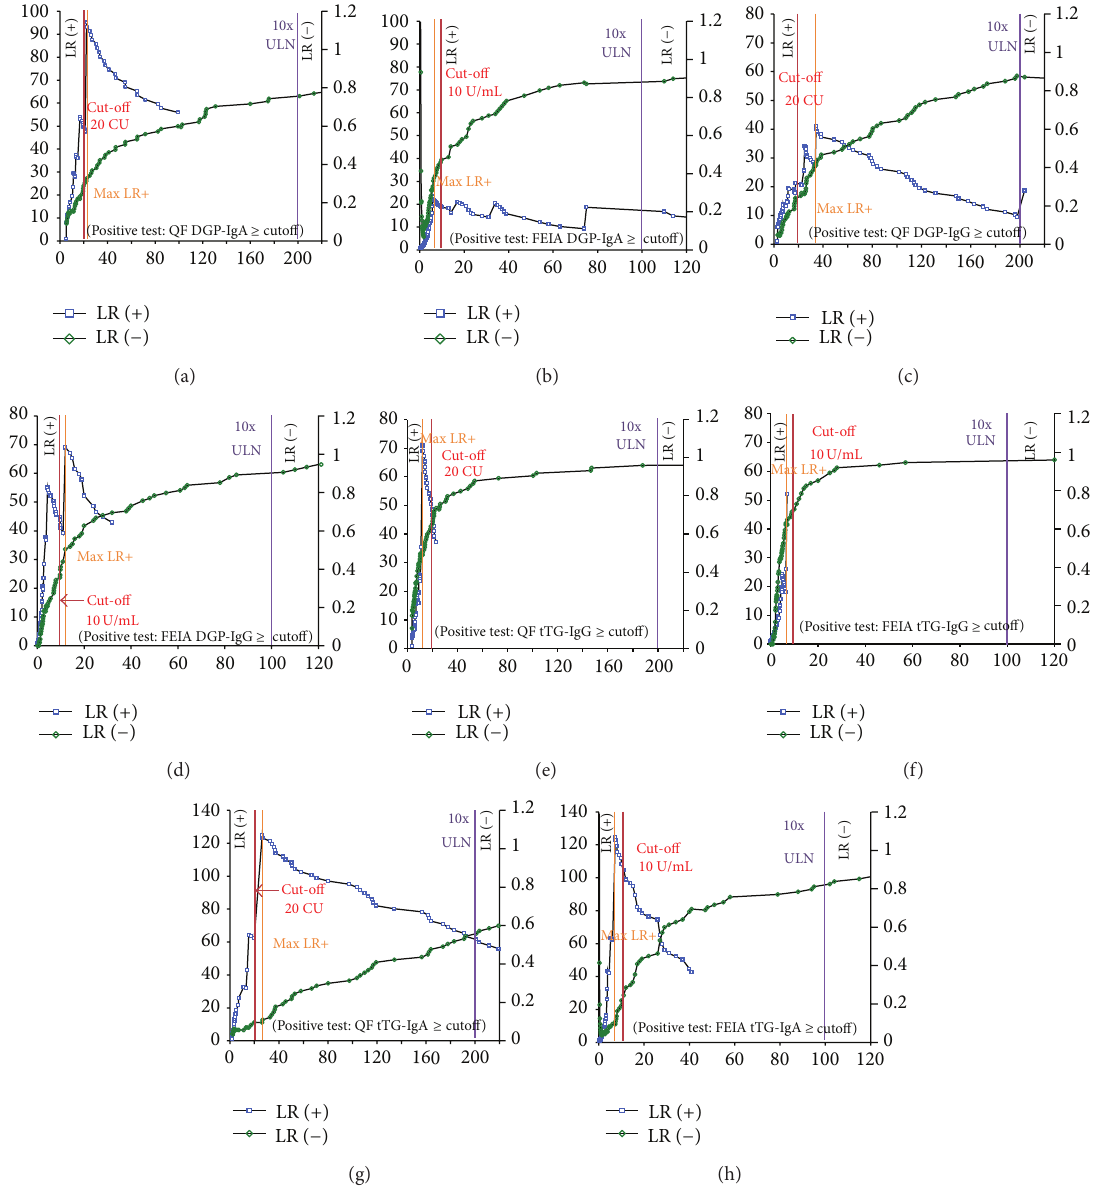
Figure 3: Likelihood ratio plots for all assays. The positive and negative likelihood ratios ( 𝑦 -axis) are plotted against the titer of the antibodies ( 𝑥 -axis). Likelihood ratios are shown at the cutoff (red line) and at the highest positive likelihood (orange line). NOTE: likelihood ratios are illustrated based on values depicted by the software and displayed in a graph. Likelihood ratios between two data points might be different from the real values. QF = QUANTA Flash; FEIA = fluoroenzyme